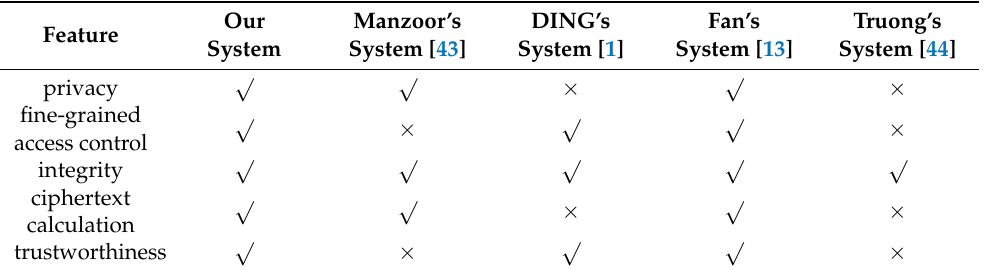
Table 1. Comparison between our system with other data protection system in the internet of things (IoT).